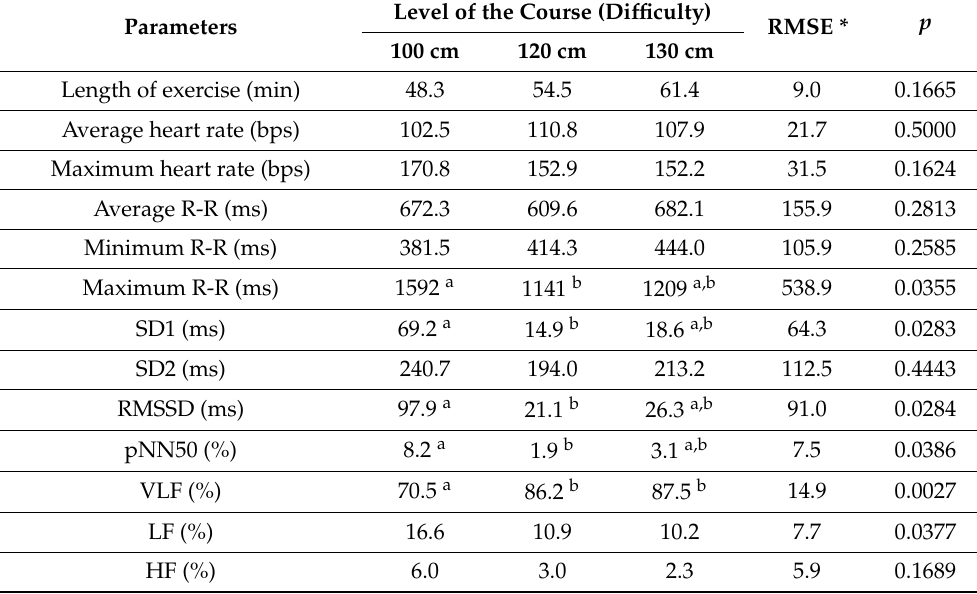
Table 1. The effect of the difficulty of the course on the heart rate and heart rate variability parameters of show jumper horses.